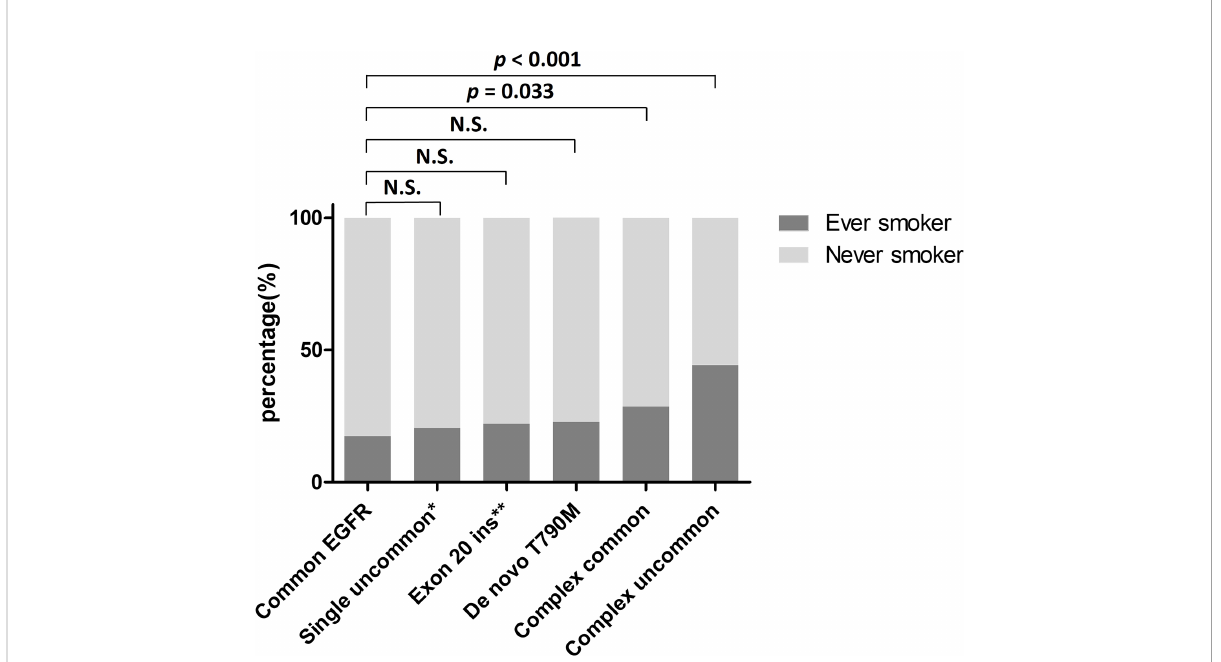
FIGURE 2 Percentage of ever-smokers in NSCLC patients harboring various EGFR mutations. *Excluding exon 20 insertion. **Including single exon 20 insertion only. EGFR , epidermal growth factor receptor; Exon 20 ins, exon 20 insertion; N.S., not signi fi cant; NSCLC, non-small cell lung